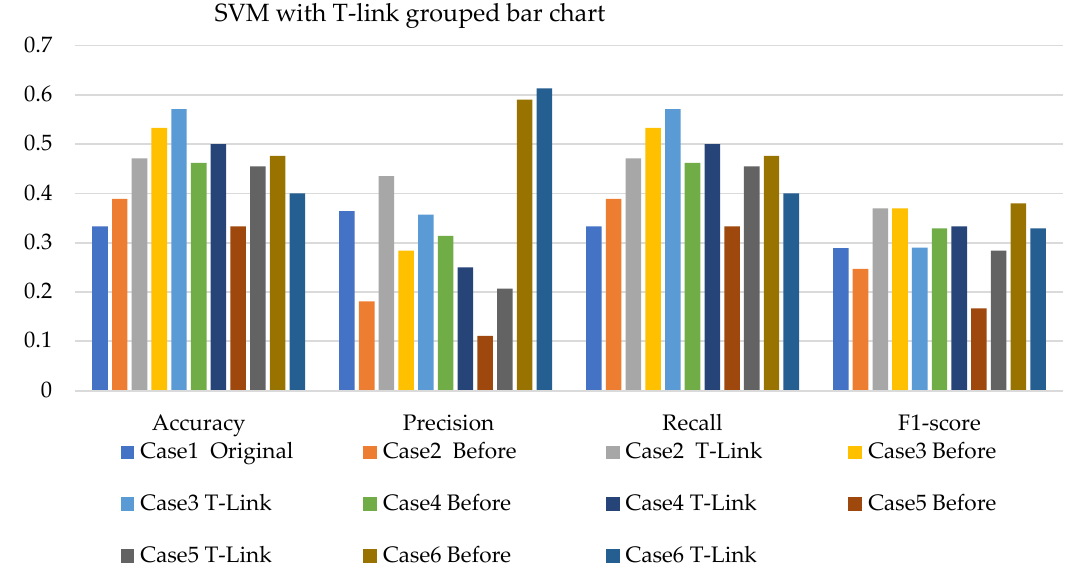
Figure 17. Experimental performance of SVM classification with SMOTE.